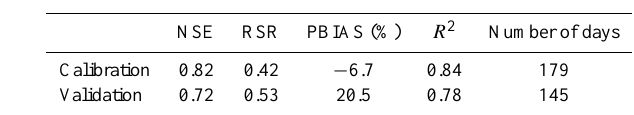
Table 1. Model performance